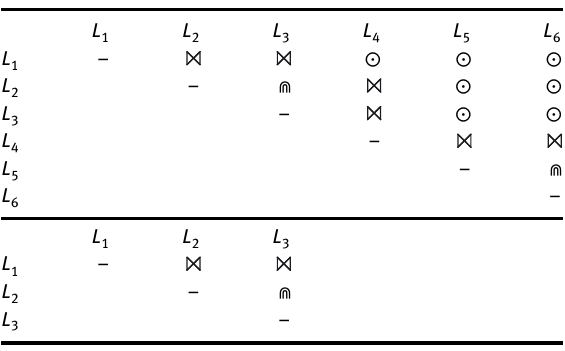
Table 3: Relation matrices of the structures in Figure 7, respectively. The two patterns into the structure are formed by loops L 1 , L 2 , L 3 and L 4 , L 5 , L 6 .